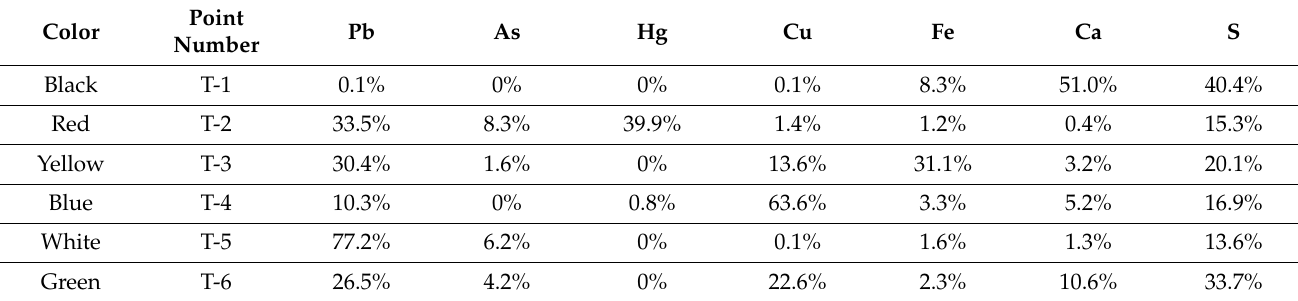
Figure 4. Statue No.CS1 in the Sage Mother Hall. Location of testing positions. Table 2. Statue No.CS1, Sage Mother Hall: XRF analyses results.